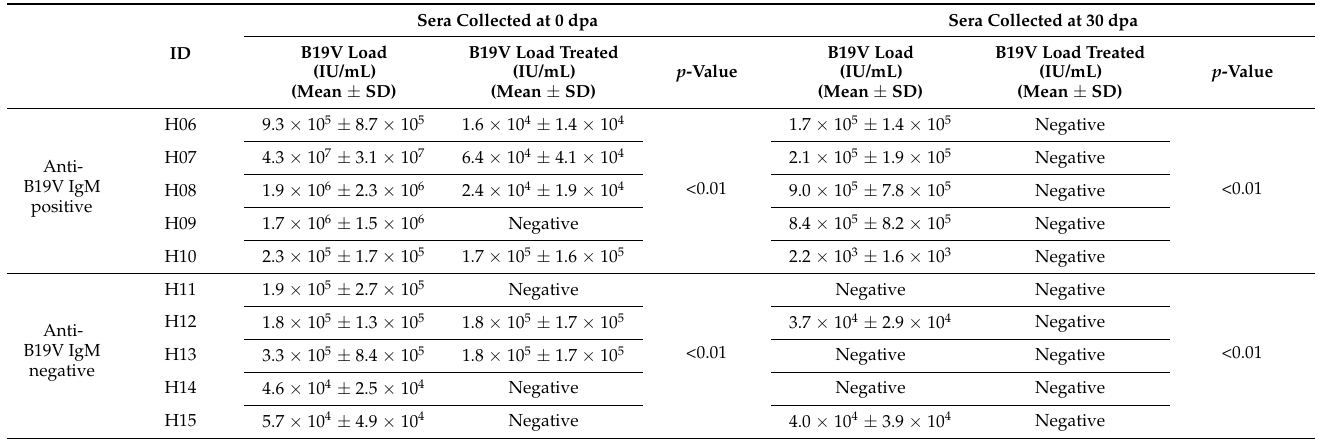
Table 2. Performance of Benzonase ® pretreatment among human sera samples from patients B19V DNA positive, according to anti-B19V IgM presence.